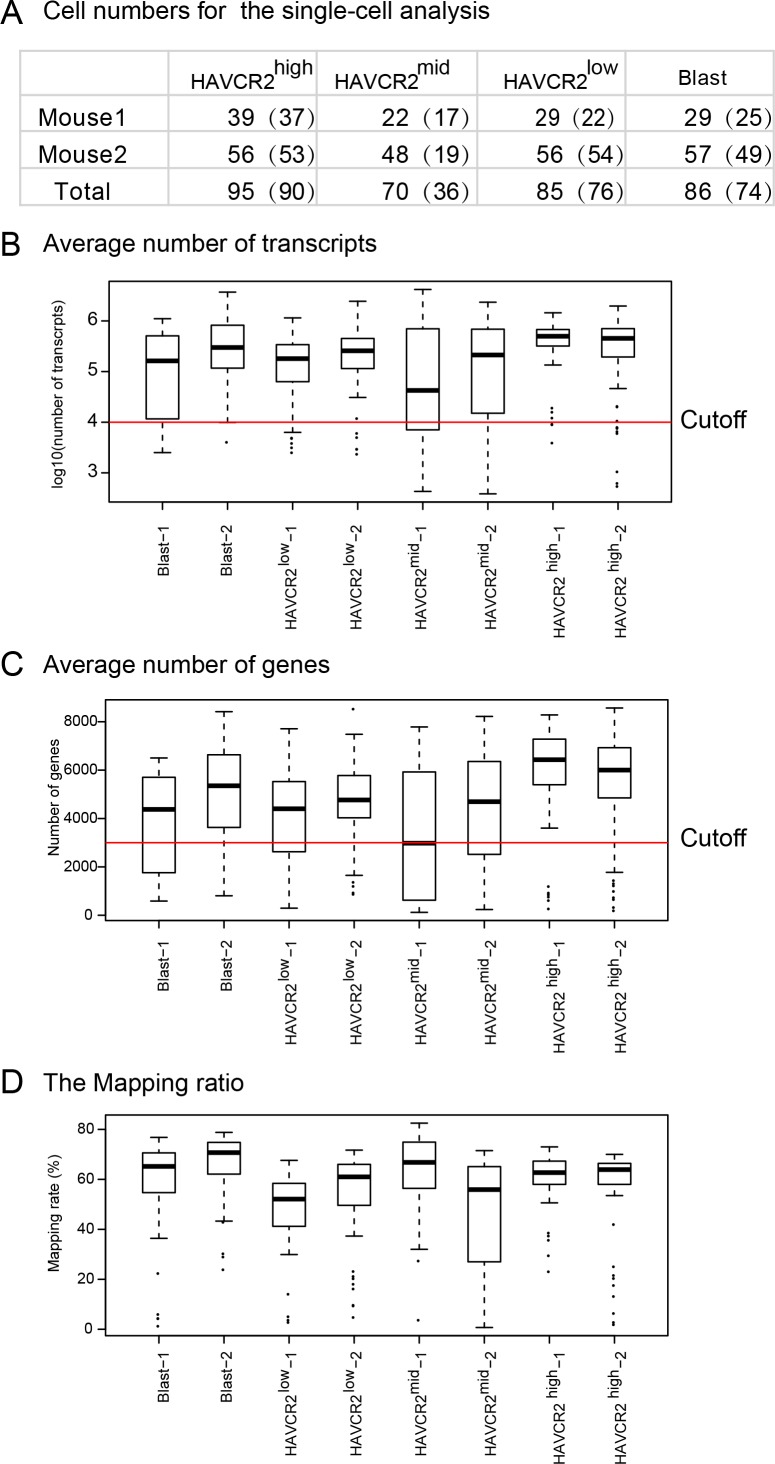
Quality control of single cell RNAseq analysis.(A) Cell numbers used for single-cell RNA-seq. The numbers in parenthesis represent the number of cells that passed the quality control and were used for further analyses; (B–C) Boxplots of the average numbers of transcripts (B) and genes (C) detected in each subgroup; (D) Mapping ratio of the raw reads in each subgroup.